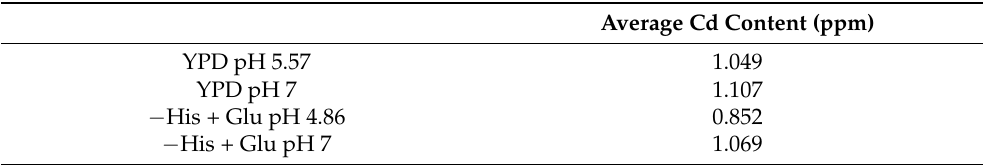
Table 4. Agglomeration assay. QDs in SD-HIS and YPD with natural pH (4.86 and 5.57) and neutral pH (pH 7). The samples were spun to isolate largely agglomerated QDs at the bottom; the supernatant was then tested using ICP-OES.